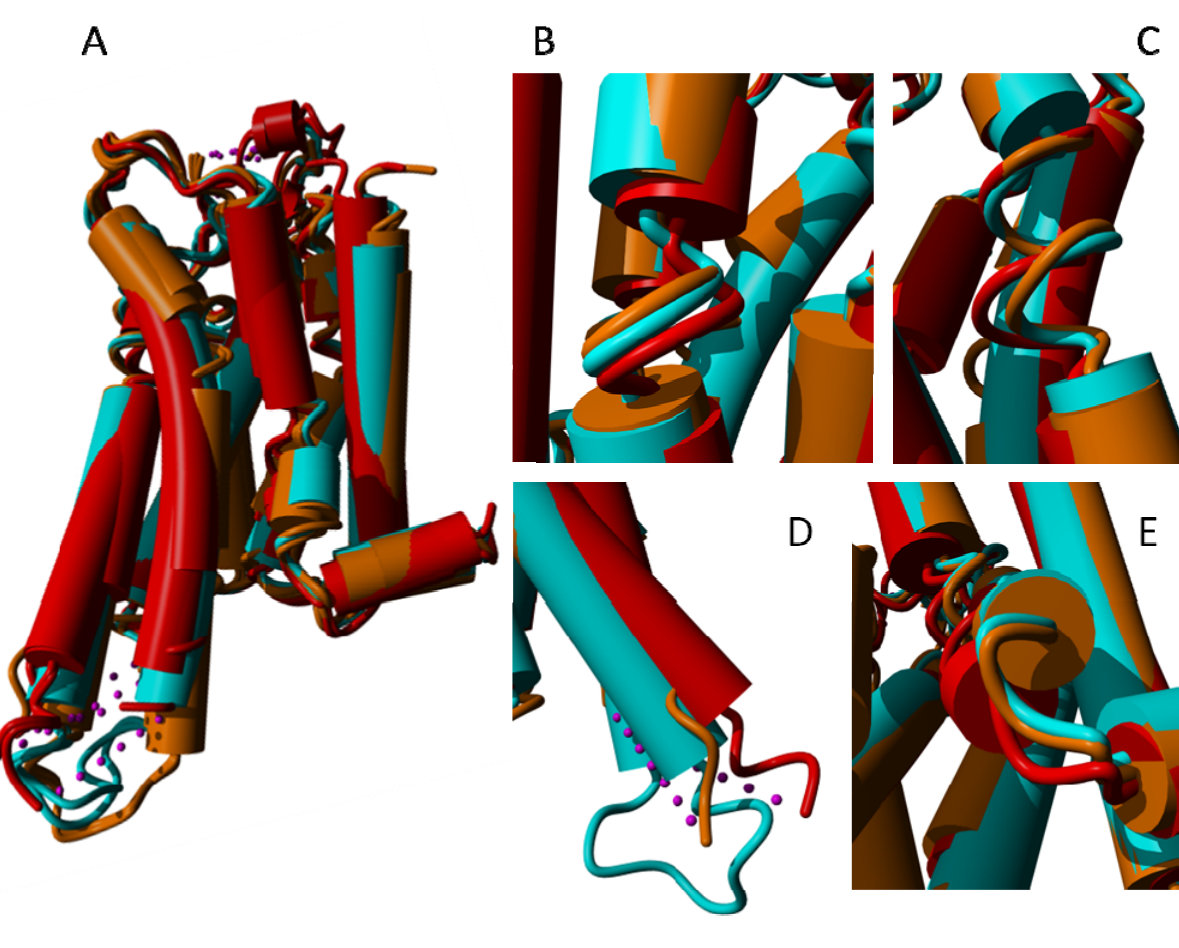
Figure 13. ( A ) Eleven adenosine 2A structures superposed. Light blue: 3vg9 [21] and 3vga [21] that each bind an inverse agonist; brown: 3eml [46], 3pwh [17], 3rey [17], 3rfm [17], 3uza [54] and 3uzc [54] that each bind an antagonist; red: 2ydo [14], 2ydv [14] and 3qak [55] that each bind an agonist. At some locations these three groups show systematic behavior that is illustrated in the blow-up of three representative structures (3vga, 3eml and 2ydo) in the panels B – E ; ( B ) Helix II shows a systematic displacement of the area around the α -bulge towards helix III in the activated receptors; ( C ) Helix V in the activated receptors shows a systematic displacement of the area around the α -bulge towards helices III and IV; ( D ) Relative to the inverse agonist bound structures (cyan), the cytosolic side of helix V moves outward when an agonist is bound and inward when an antagonist is bound; and ( E ) The loop between helix VII and helix VIII behaves systematically (albeit in a hard to describe way) as function of the type of ligand bound, in line with the crucial role in the activation process for mobility of